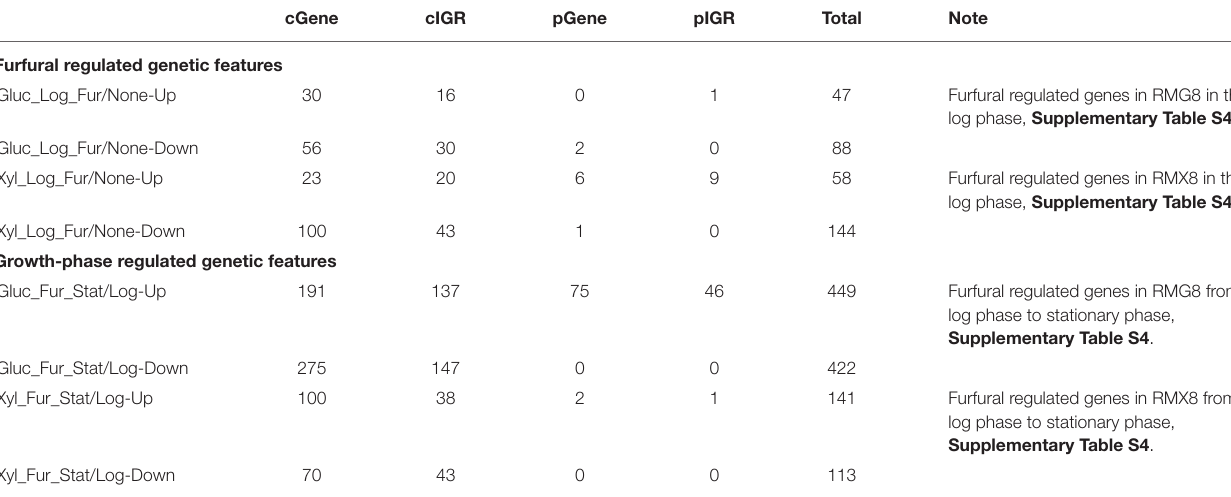
TABLE 3 | Summary of significantly differentially expressed genes in response to furfural or carbon sources in long-term stress response